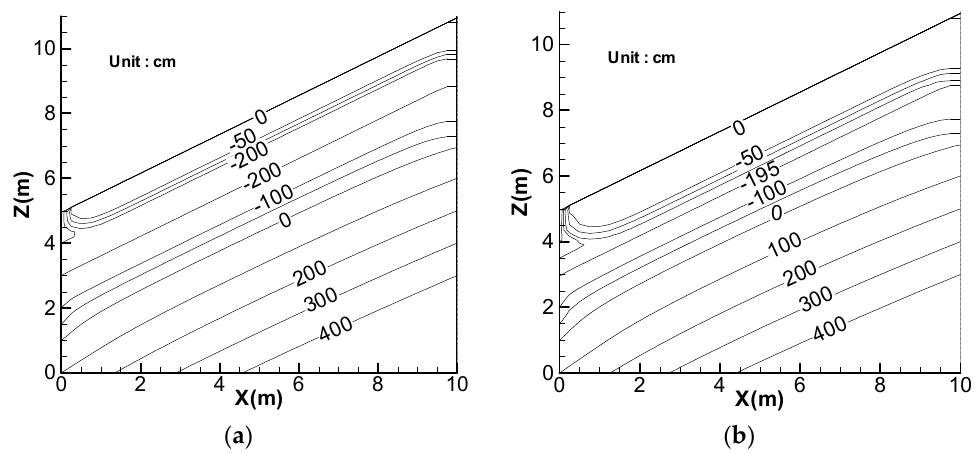
Figure 8. Pressure head contours for duration of 6 h with uniform rainfall of 400 mm at time: ( a ) 3 h; and ( b ) 6 h.